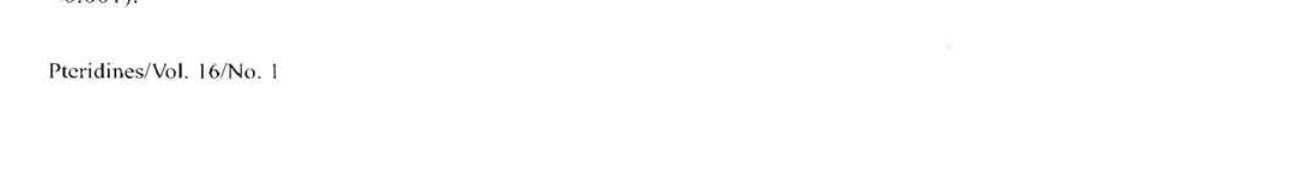
Figure 3. Serum concentration (mean ± S.E.M.) of total homocysteine in healthy individuals (open bars) and in C AD patients before percutaneous transluminal coronary angioplasty due to 1-artery disease (dotted bars), 2- or 3-artery disease (hatched bars), and in pa- tients with restenosis (black bars). *The changes are significant if compared with healthy individuals (P <0.001).